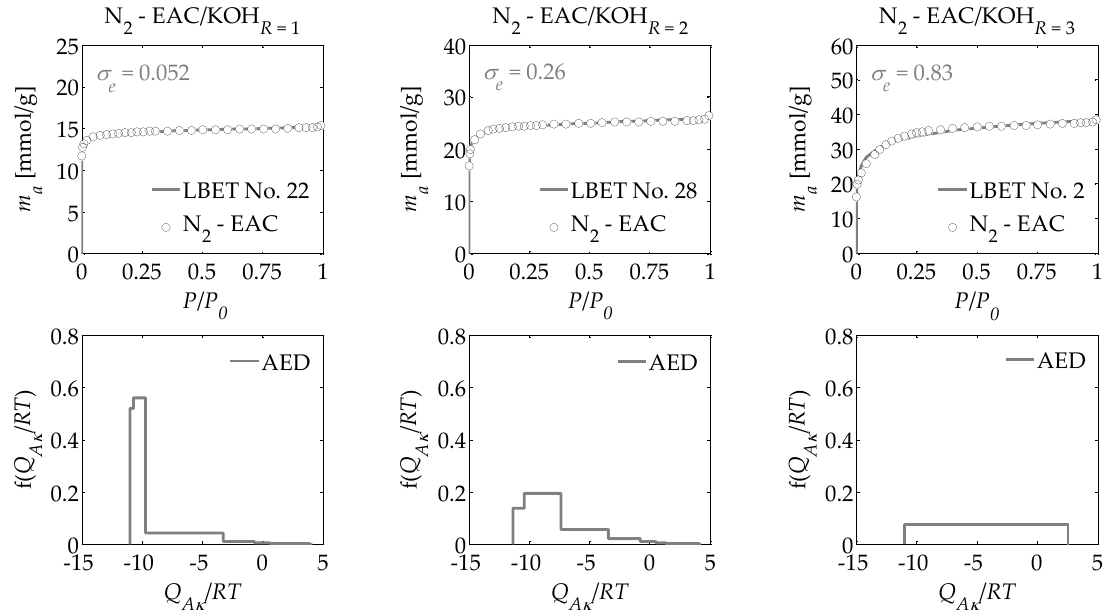
Figure 2. The same as Figure 1 but for the activated carbons EAC prepared from ebony wood.